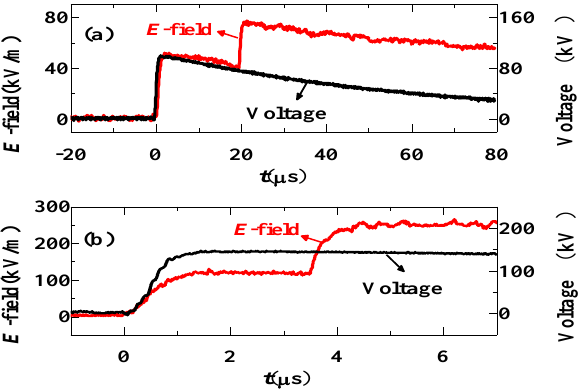
Figure 25. Typical results of E-field at 70 cm above the plane ( a ) with applied voltage of 100 kV and ( b ) with applied voltage of 150 kV [85] (Copyright © 2011 AIP, Reprinted with